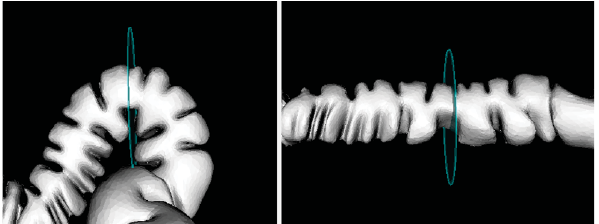
Fig. 8 Five examples of GC deformation. Left: original GC. Middle, right: deformed shapes; the target centerline shapes are parametric curves. (a) Flexible tube, (b) pencil, (c) human colon, (d) snake, (e) cane.